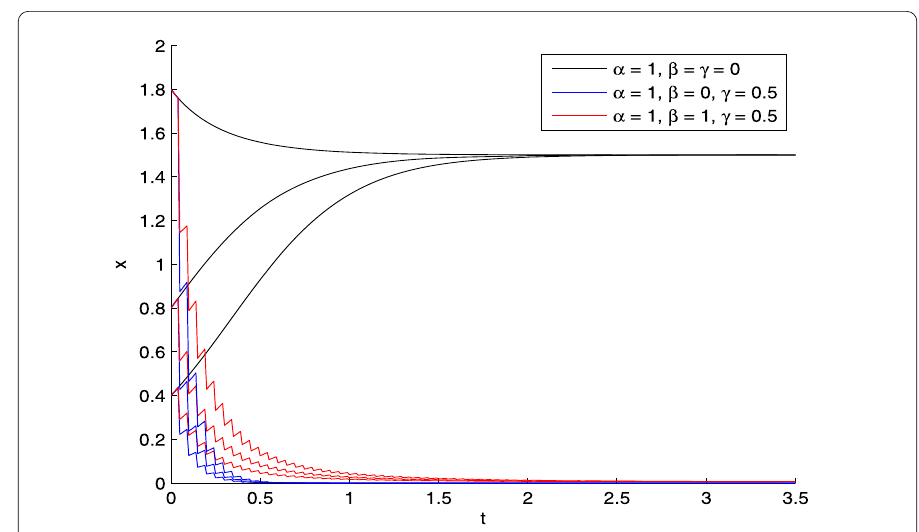
Figure 2 Dynamic behaviors of the species x ( t ) in system (1.4) with the initial conditions x (0) = 0.4, x (0) = 0.8, x (0) = 1.8, respectively